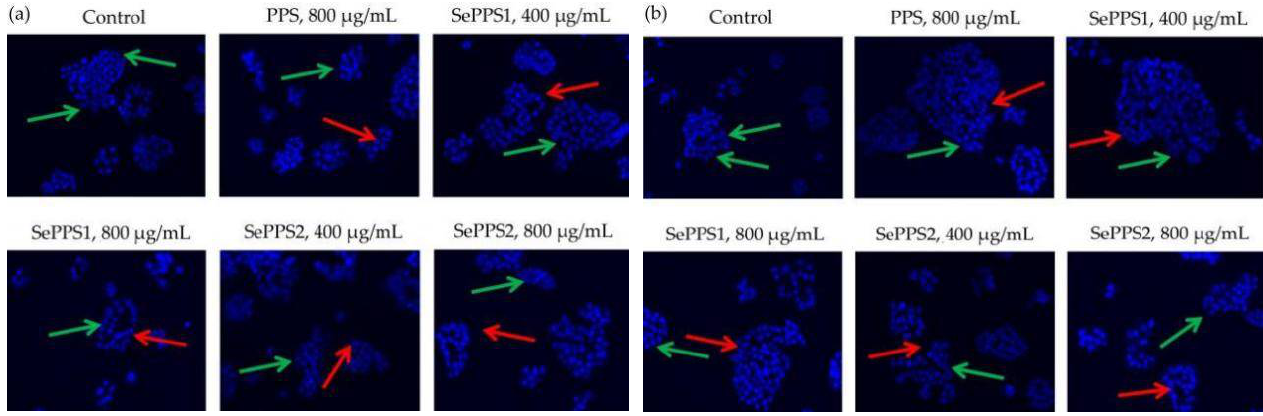
Figure 3. Hoechst 33258 staining results for HCT-116 cells treated with P. oleracea polysaccharides (PPS) and two selenylated PPS products (SePPS1 and SePPS2) at two dose levels for 24 ( a ) and 48 h ( b ), respectively. The green arrows indicate the normal cells, while the red ones indicate the apoptotic cells.